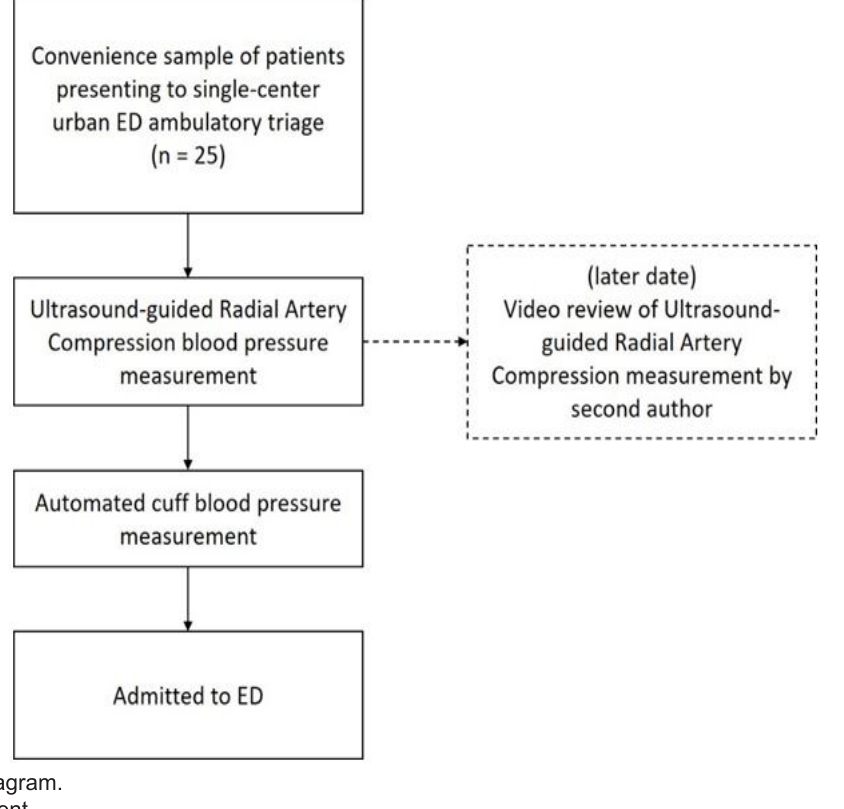
Figure 1. Patient flow diagram.